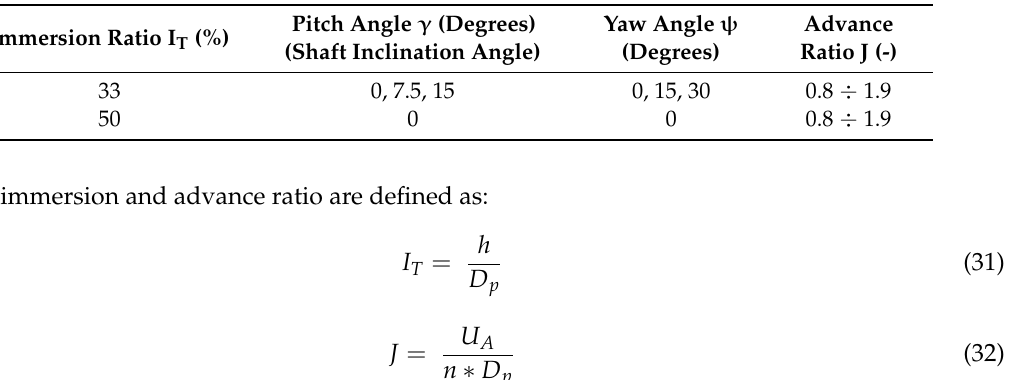
Table 3. Test condition settings of surface-piercing propeller (SPP).